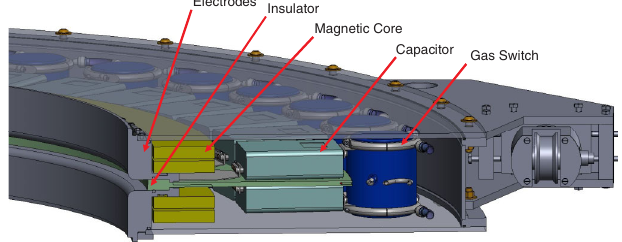
FIG. 1. (Color) Cross-sectional view of the 1-MA LTD cavity indicating the locations of the major components, including the gas switch, capacitors, and magnetic